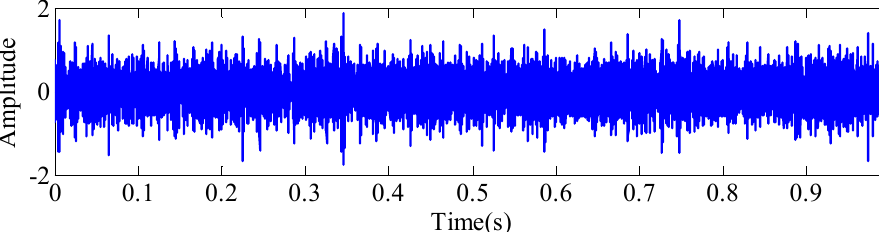
Figure 15. Noise reduction diagram of the signal segments selected by this algorithm.